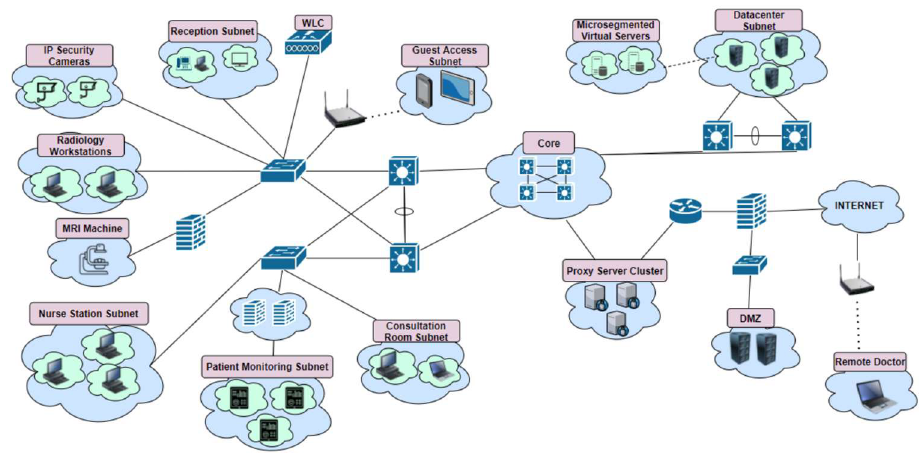
Figure 4. Base network topology for a hypothetical healthcare organisation.